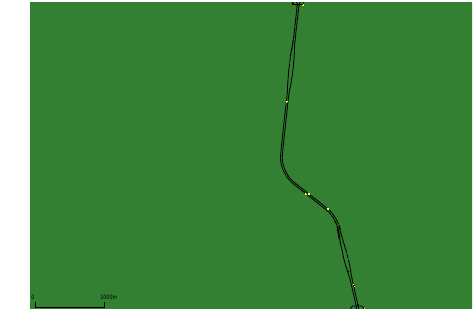
Figure 2. Urban scenario.